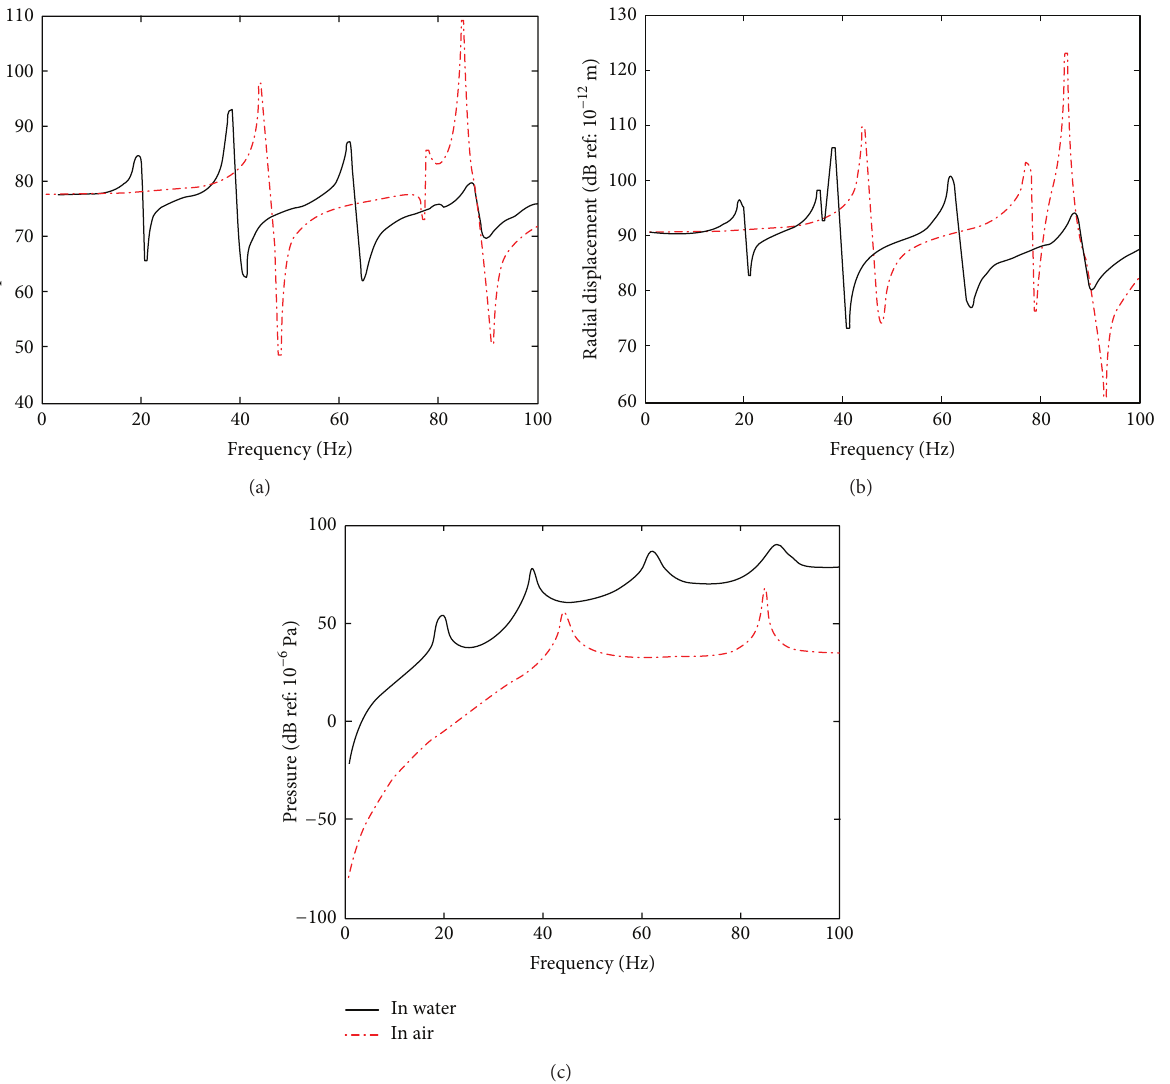
Figure 12: Comparison of conical shells in water and in air, under 𝐹 2 (a) axial displacement, (b) radial displacement, and (c) far-field